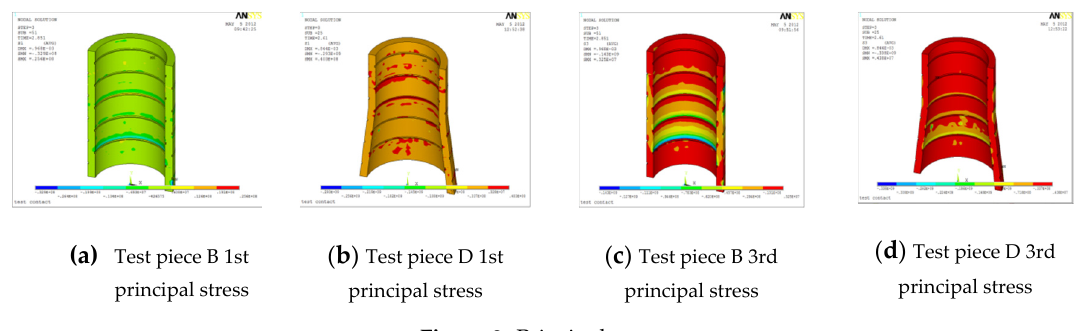
Figure 9. Principal stress.